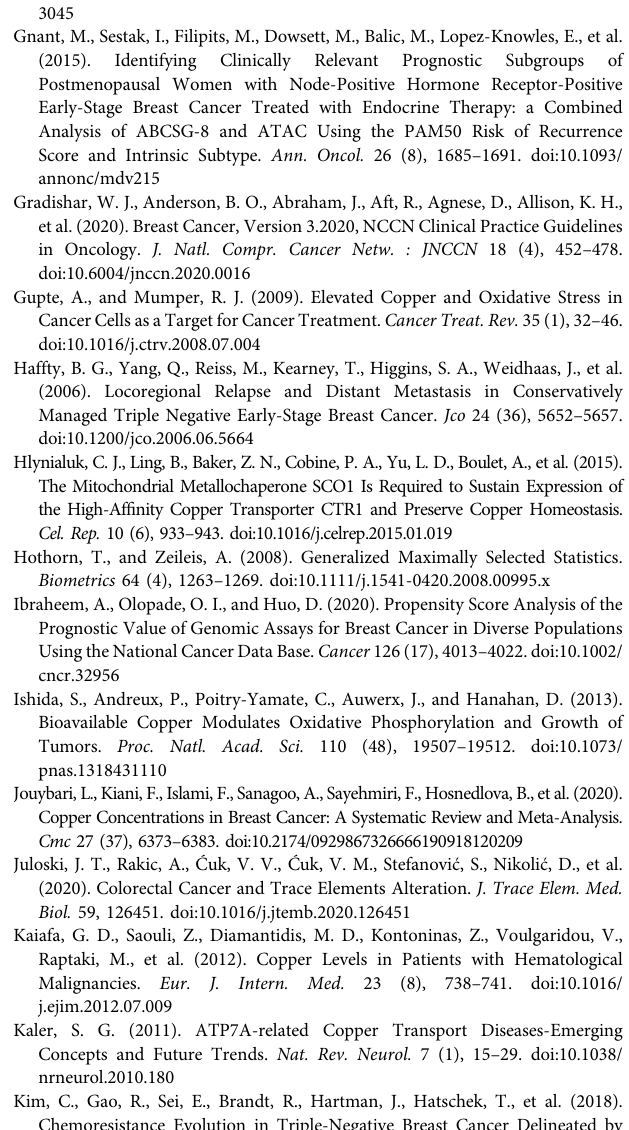
Supplementary Figure S1 | Determination of the cut-off value of serum copper level and survival analyses. X-tile analysis of 10-year OS was performed using the patients ’ data to identify the best cut off value for serum copper level. The optimal cut-off points highlighted by the black circles in the left panels are shown as histograms of the entire cohort (middle panels), and Kaplan-Meier plots are displayed in the right panels. The optimal cut-off value for serum copper level was 21.3 μ mol/L ( χ 2 (cid:1) 11.5172, P (cid:1) 0.0189). Supplementary Figure S2 | Kaplan-Meier survival curves with log-rank test in the training cohort. A: Kaplan-Meier estimates of disease-free survival (DFS) probability. B: Kaplan-Meier estimates of overall survival (OS)